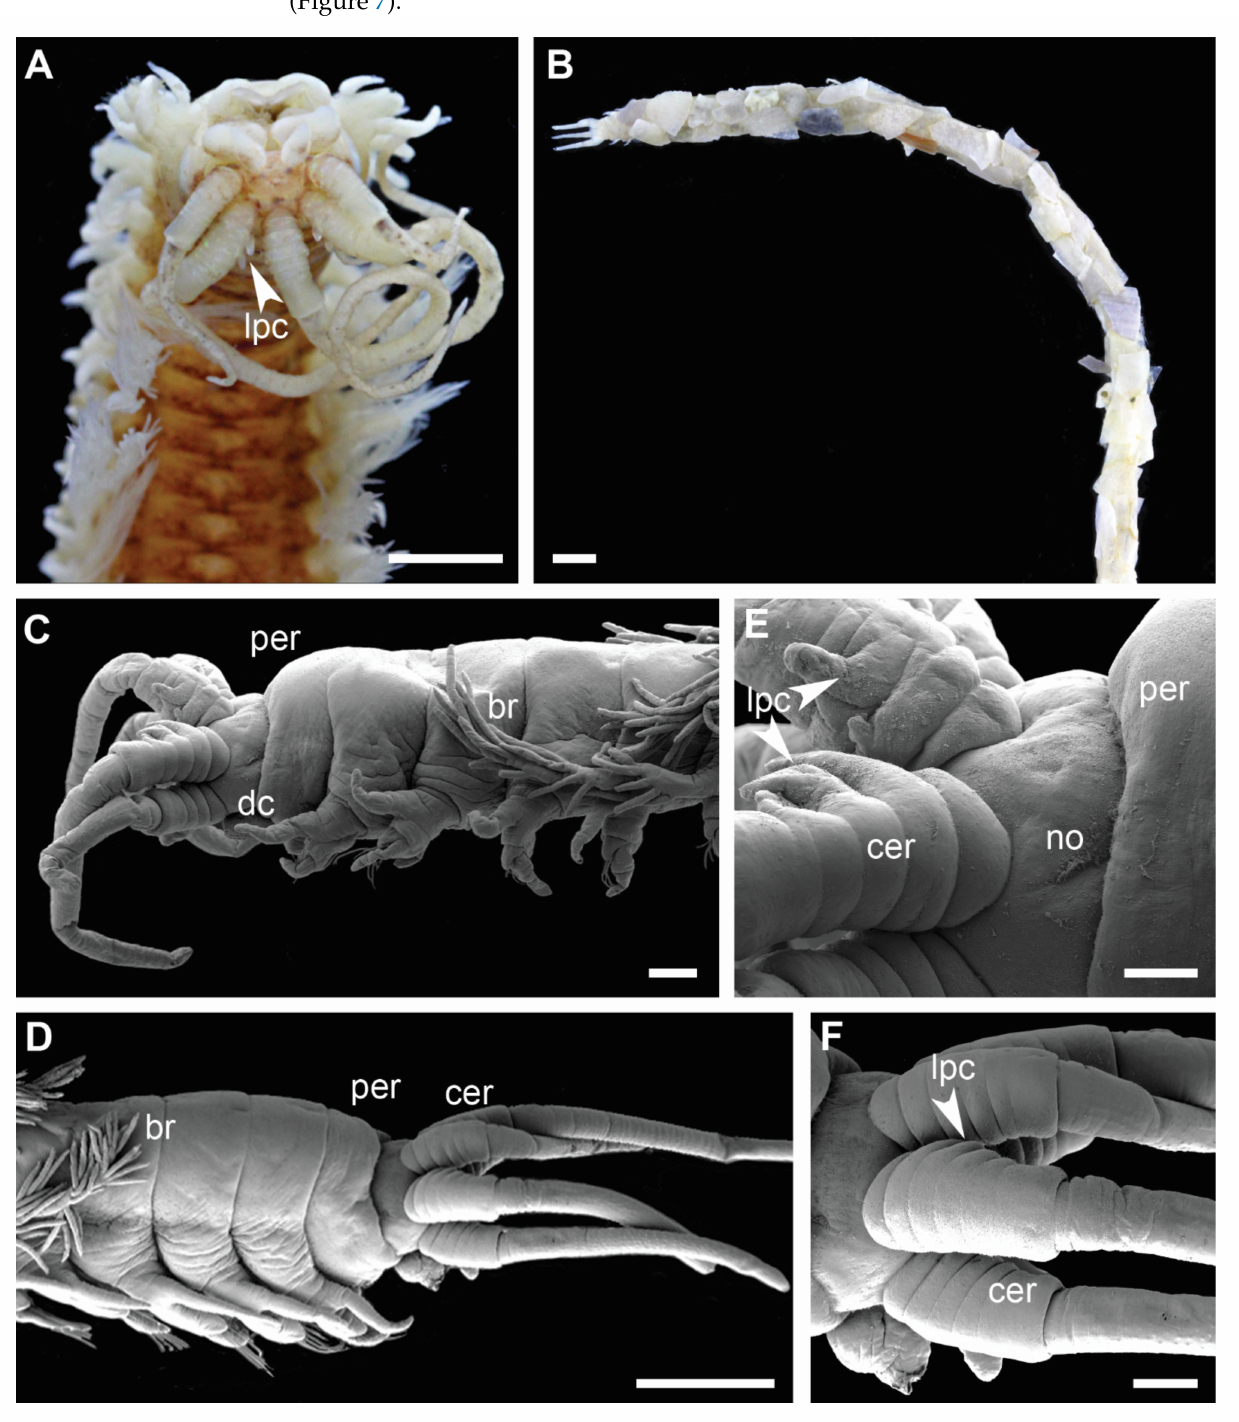
Figure 5. Morphology of Diopatra species representing Clade 4. ( A , B )—light microscopy photographs; ( C – F )—scanning electron microscopy images. ( A ): Diopatra cf. dubia ZMBN145685, anterior fragment with lateral projections on ceratophore rings, dorsal view; ( B ): Diopatra sp. 16 ZMBN145684, anterior fragment in a tube, lateral view; ( C ): Diopatra sp. 16 ZMBN145683, enlarged, showing